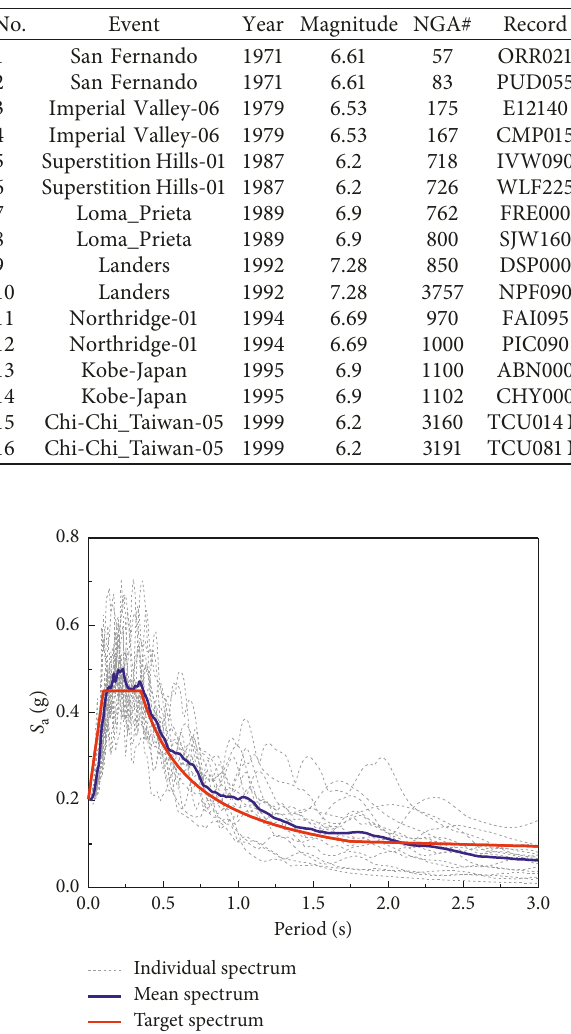
Table 6: Earthquake